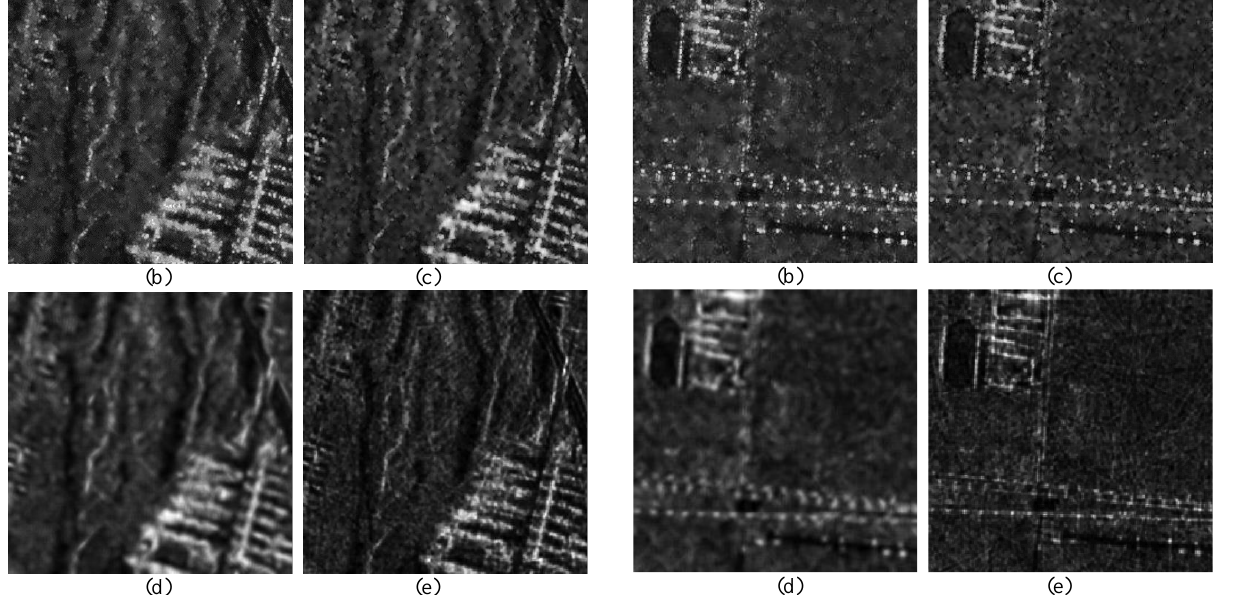
Fig 4. Despeckling results: (a) original image, (b) Lee filter, (c) Gamma MAP filter, (d) improved non-local means, (e) our method.